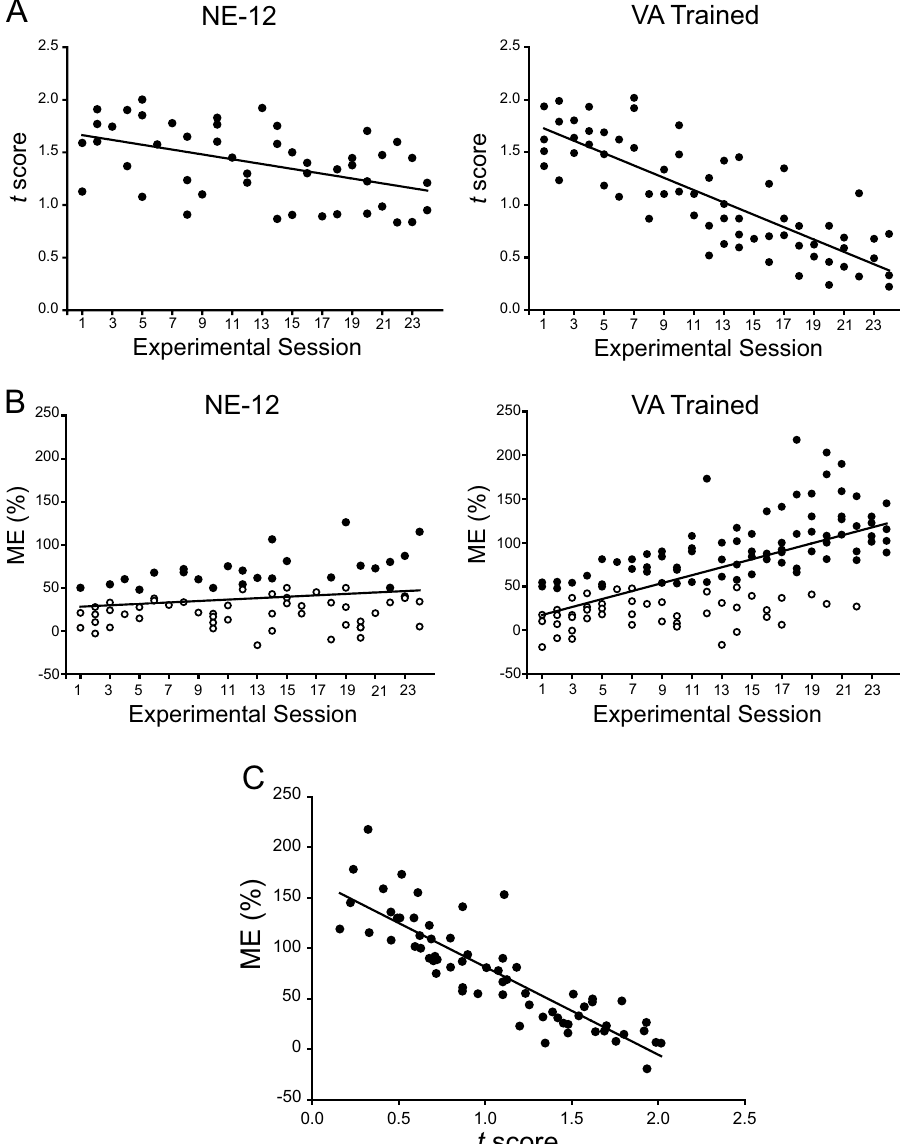
Figure 8. Population data showing the time course of receptive field register and multisensory integration capabilities over the cross-modal exposure sessions relative to controls. ( A ) While the t -score representing visual-auditory RF register remained high (misalignment) in noise-reared animals subsequently housed in the normal environment for 12 months (NE-12), the t score in animals in the cross-modal trained group gradually decreased. ( B ) Similarly, while there was no significant increase in either the incidence of neurons showing multisensory integration capabilities (filled circles) or their enhancement index in the NE-12 animals, these scores gradually increased to reach adult-like levels for neurons in the VA trained group. ( C ) Improvements in RF register and ME were highly correlated on a sample-by-sample basis: neurons with greater levels of RF register more likely to show higher levels of multisensory enhancement (r = −